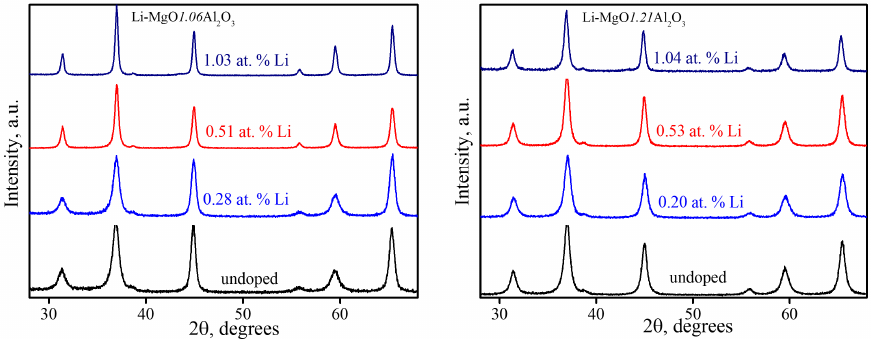
Figure 1. XRD patterns of as-synthesized powder samples.